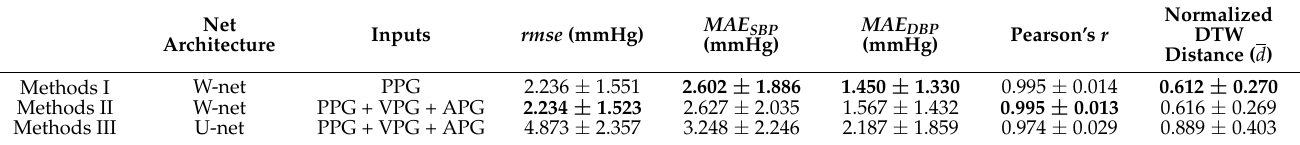
Table 1. Comparison of the model’s performance in different settings. The rmse and r stand for the root mean squared error and Pearson’s correlation coefficient, respectively, and MAE SBP and MAE DBP stand for the mean absolute error between the systolic and diastolic blood pressure, respectively. The bold indicates the best performance in each evaluation metric. Note that PPG = Photoplethysmogram, VPG = Velocity PPG, APG = Acceleration PPG, SBP = Systolic blood pressure, DBP = Diastolic blood pressure, and DTW = Dynamic time warping.